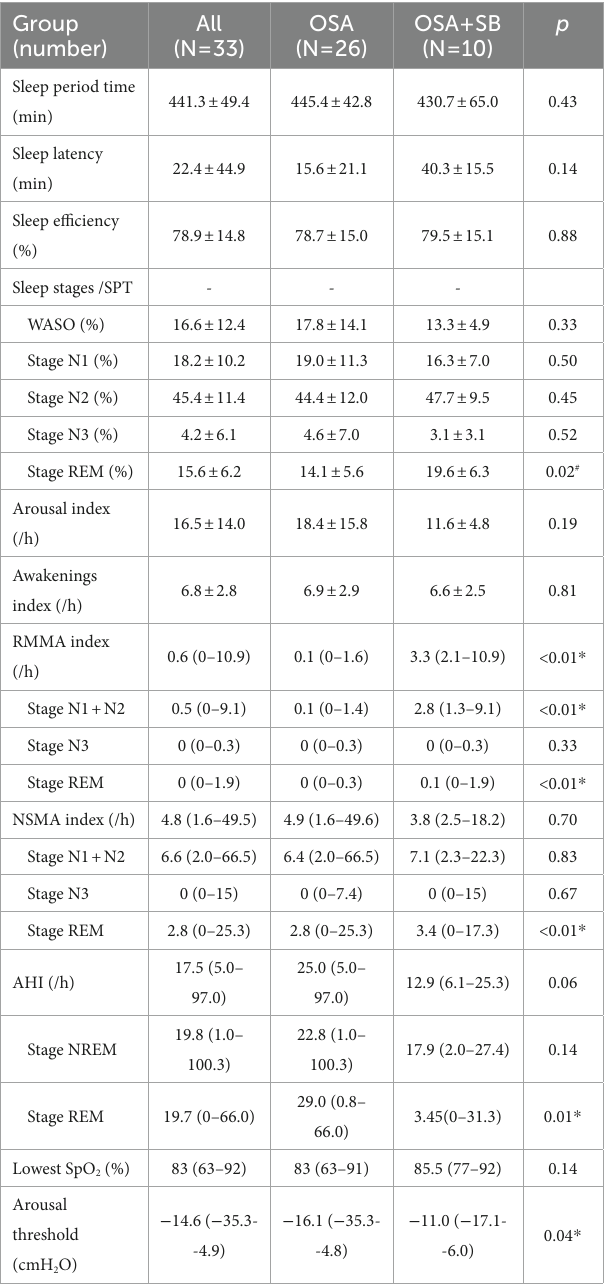
TABLE 2 Comparison of sleep variables and oromotor events in subjects with and without SB in the OSA